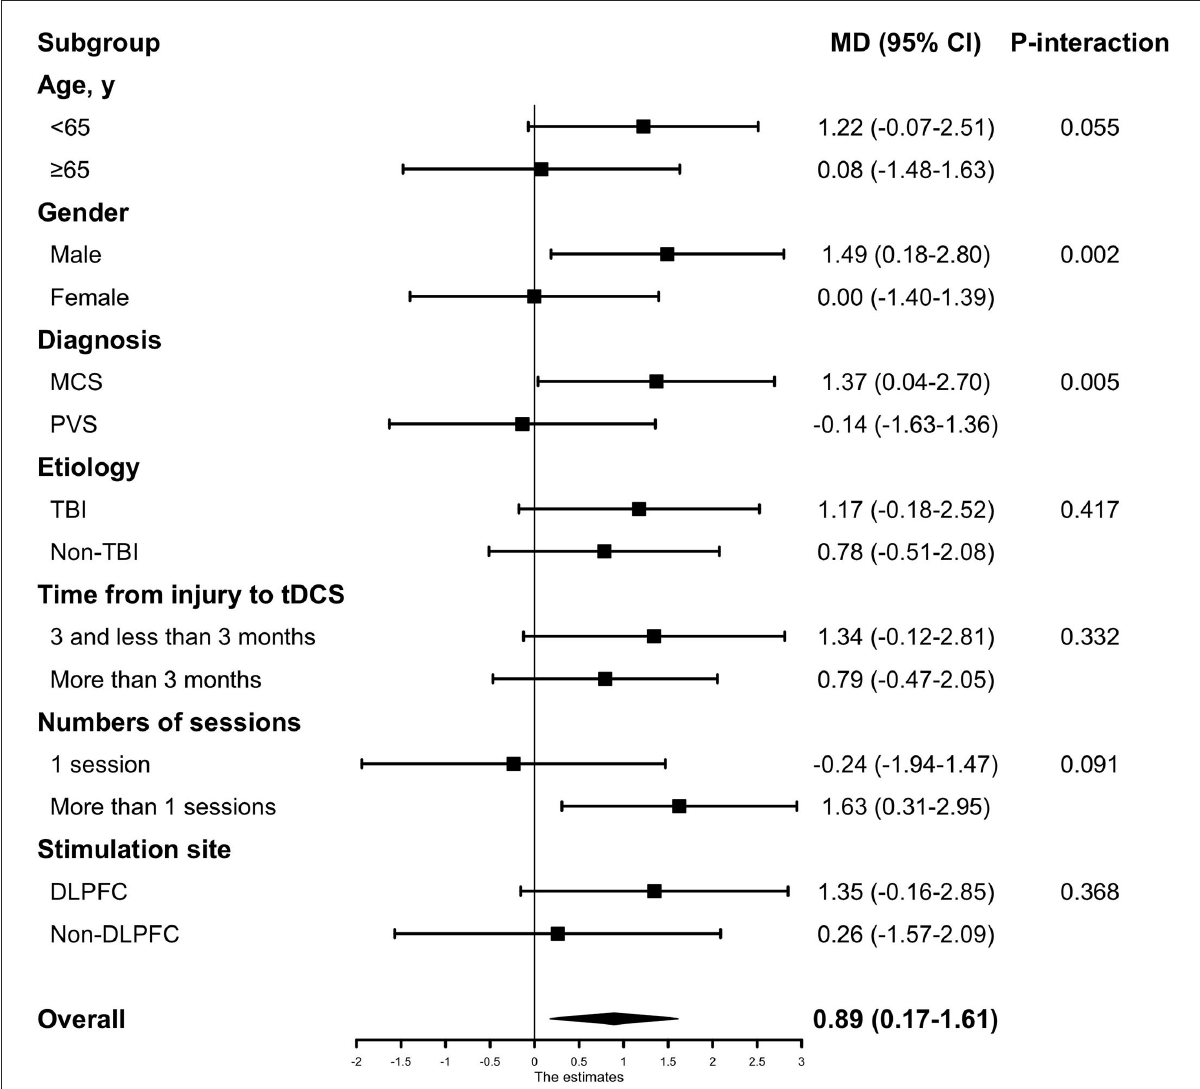
FIGURE3 The subgroup analyses based on baseline characteristics and tDCS protocols. Subgroup analyses were adjusted by patients’ baseline covariates. Non-TBI included Intracerebral hemorrhage (ICH), anoxia, and stroke. MCS, minimally conscious state; PVS, persistent vegetative state; TBI, traumatic brain injury; DLPFC, the dorsolateral prefrontal